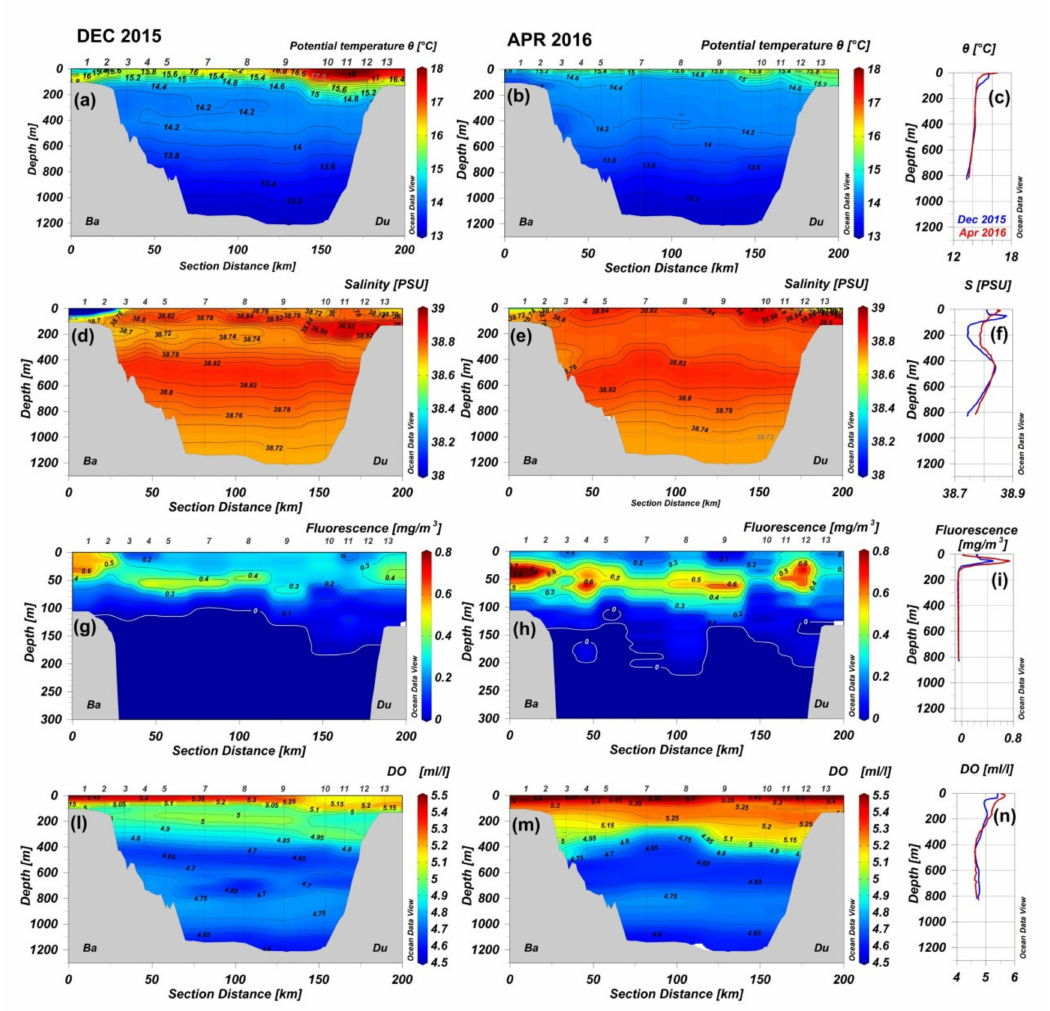
Figure 2. Vertical distribution of potential temperature ( a – c ), salinity ( d – f ), chlorophyll a (by fluorescence), ( g – i ) and dissolved oxygen concentration ( l – n ) along the investigated transect in December 2015 and in April 2016 (from Njire et al., 2019 [20]). For the northernmost station ESAW-GG (see Figure 1 for its location) the corresponding vertical profiles are presented